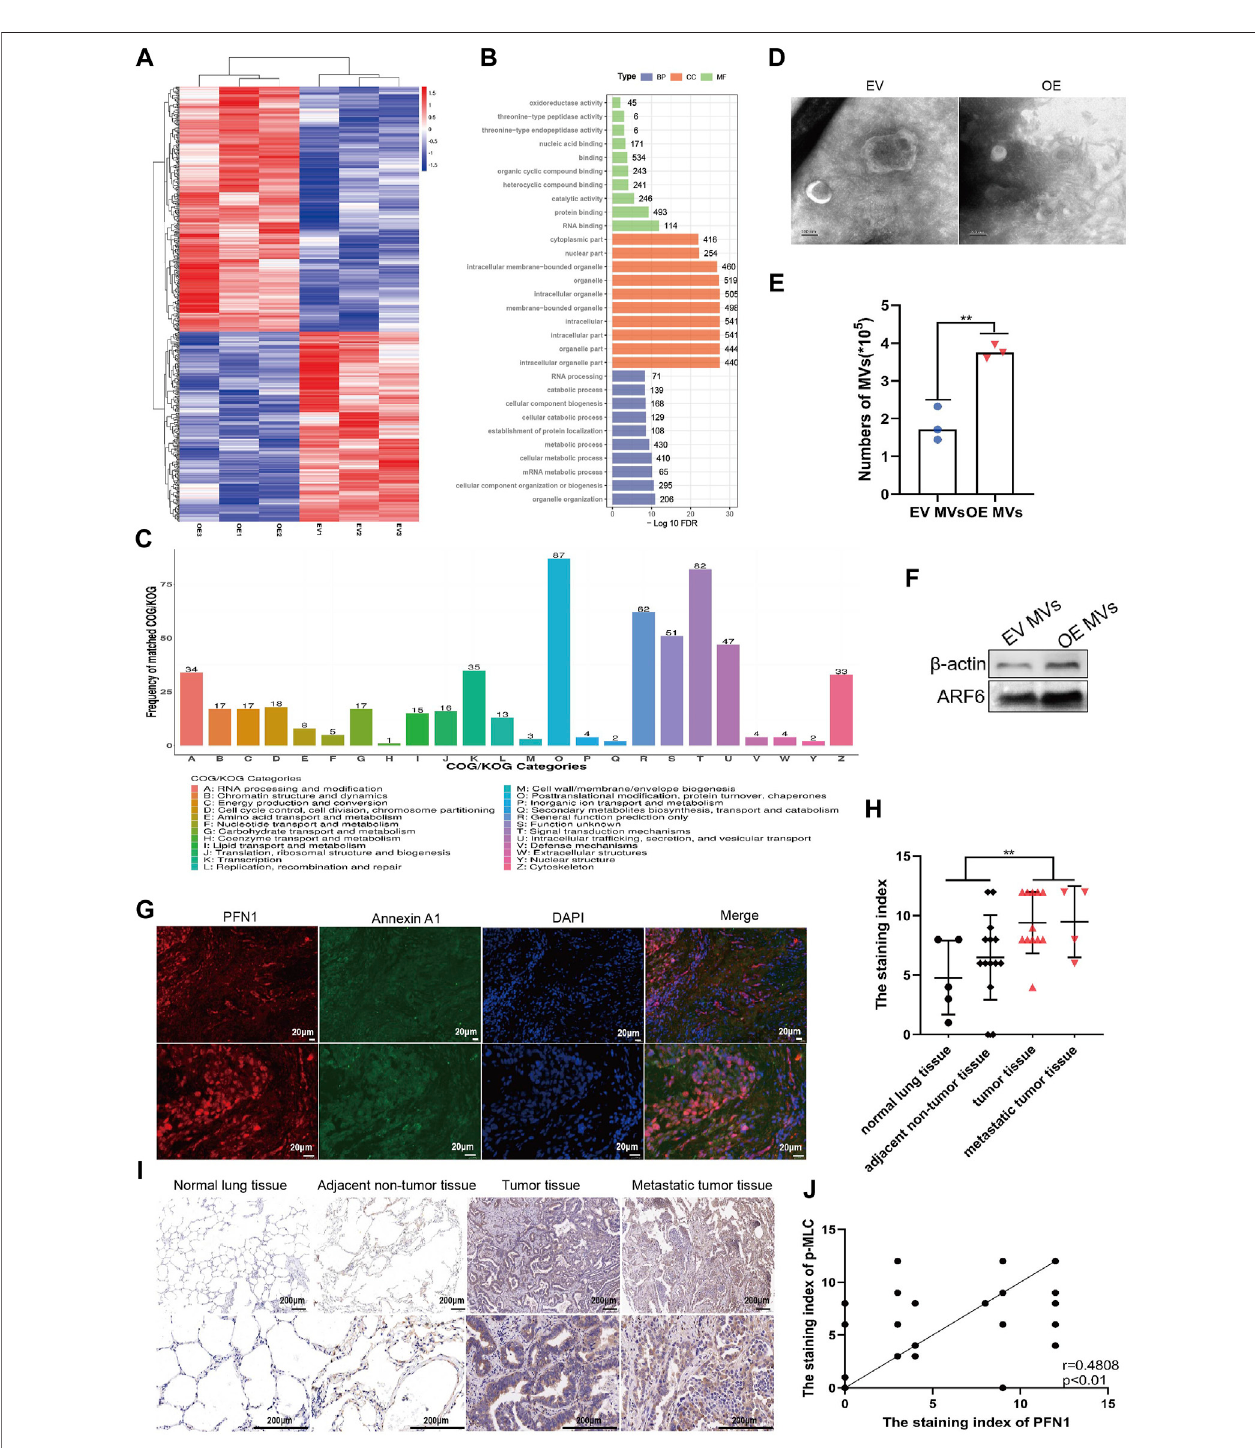
FIGURE 2 | PFN1 could promote MVs secretion in NSCLC. (A) Heatmap of differentially expressed proteins between EV and PFN1 OE cells. (B) GO enrichment analysisofdifferentiallyexpressedproteins. (C) COG/KOGanalysisofdifferentiallyexpressedproteins. (D) MVsextractedfromEV-expressingand PFN1 -overexpressing cells,usingcontinuousdifferentialcentrifugation,identi fi edusingtransmissionelectronmicroscopy.Scalebar,100 nm. (E,F) Flowcytometry (E) andwesternblotting (F) wereusedtoquantify MVsin PFN1 -overexpressingandEV-expressingcells.ARF6andactinwereused asMVmarkers. (G) ExpressionofPFN1andannexinA1in lung tumor tissues detected using immuno fl uorescence. (H) The staining index of p-MLC on the tissue chip. ** p < 0.01. (I) Representative IHC images of p-MLC expression. (J) Spearman rank correlation analysis was used to assess the relationship between PFN1 and p-MLC expression on the tissue chip; p and r values are shown in the